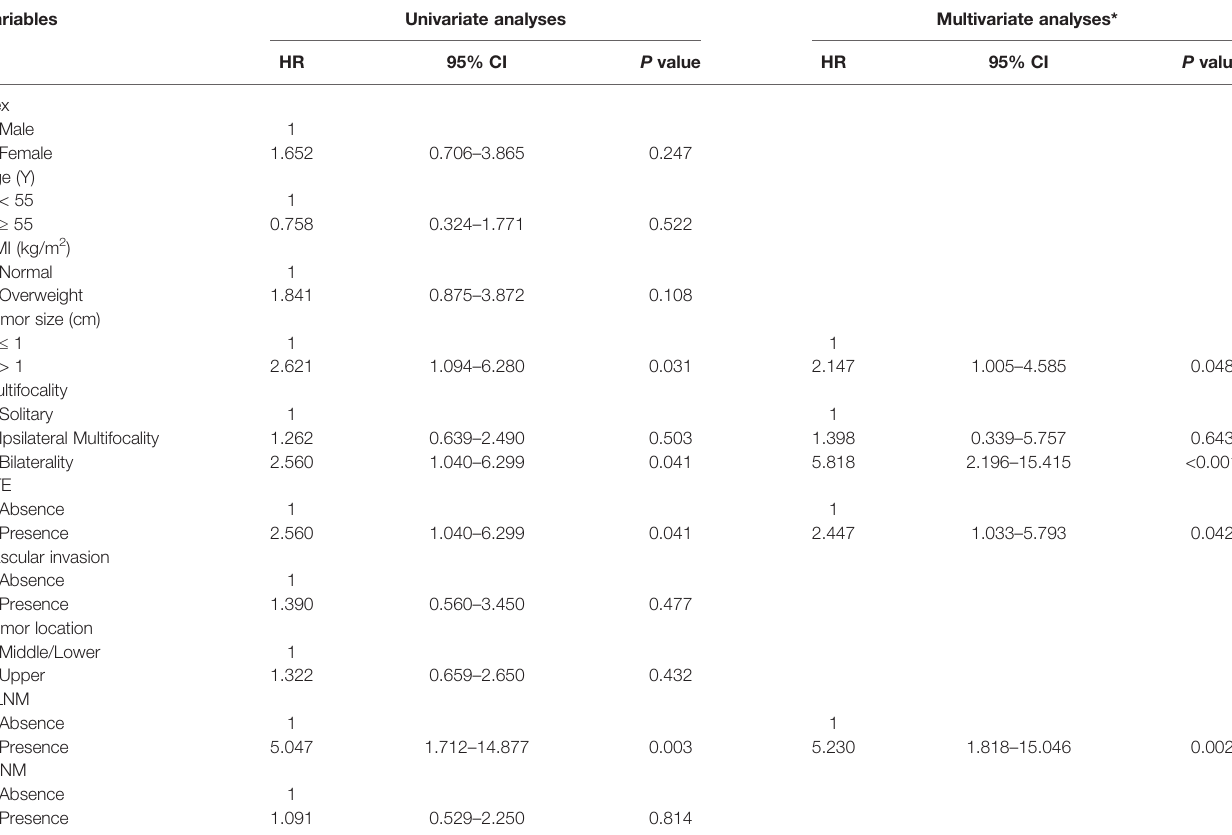
TABLE 4 | Cox proportional hazards model demonstrating factors associated with recurrence-free survival in PTC patients.